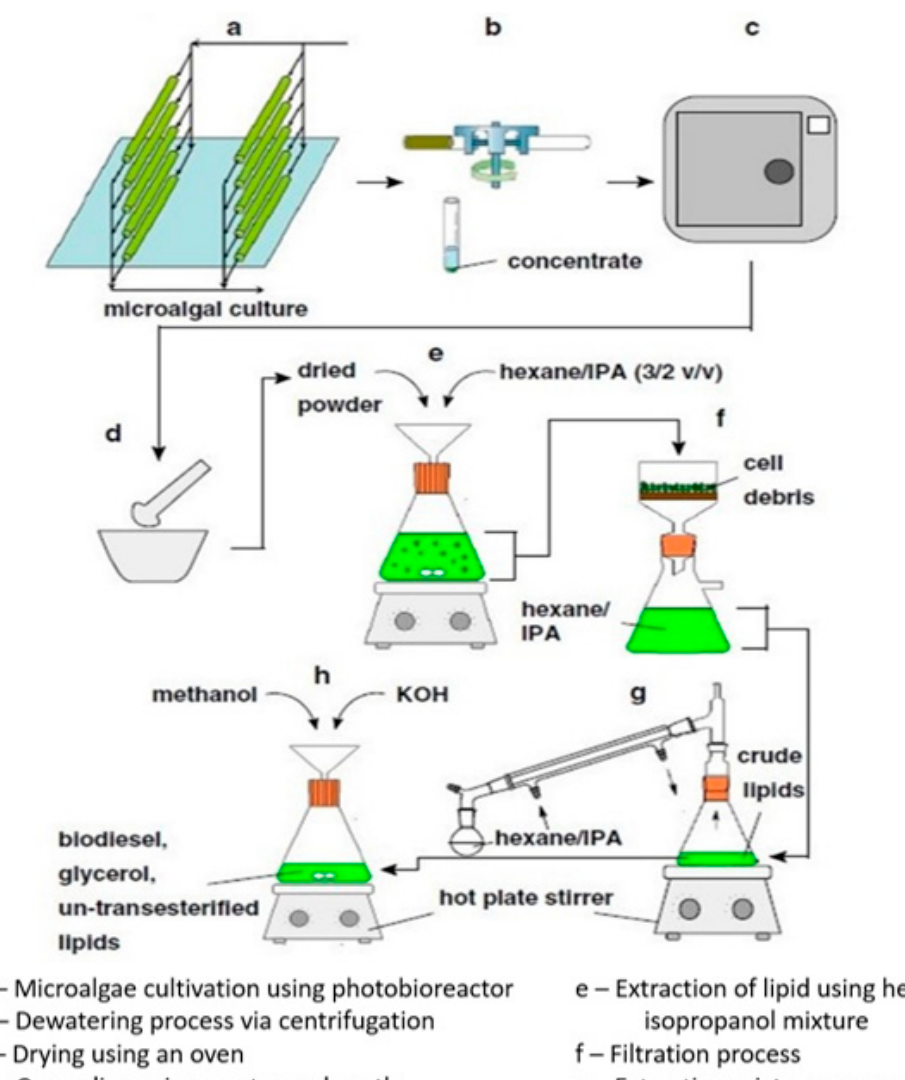
Figure 4. The typical laboratory-scale experimental procedures for producing biodiesel from microalgae biomass using the organic solvent mixture for lipid extraction [69].